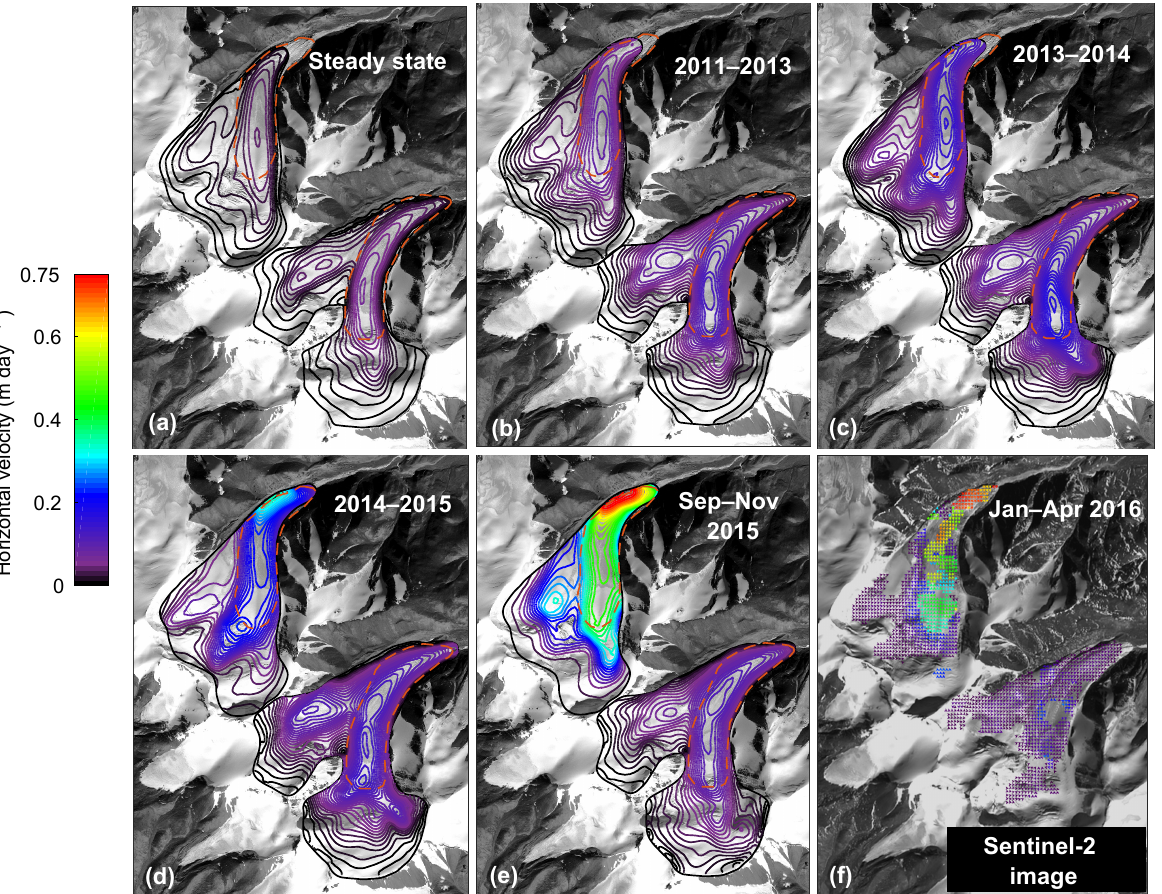
Figure 7. (a–e) Modelled mean horizontal velocities for the two glaciers at steady state and for the periods 2011–2013, 2013–2014, 2014–2015, and September to November 2015. (f) Measured horizontal velocities from Sentinel-2 image correlation between January and April 2016 (adapted from Kääb et al., 2018). Orange dashed lines indicate the detachment outline.